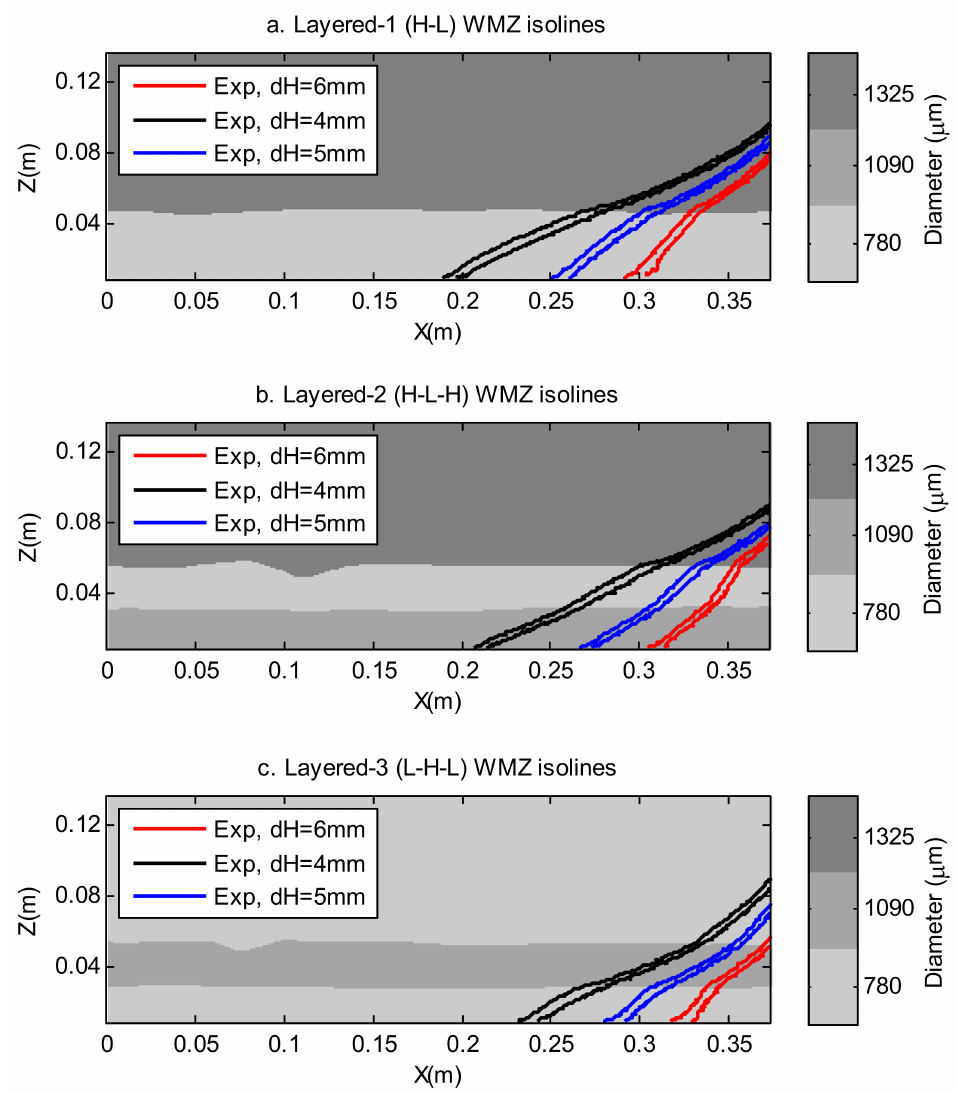
Figure 10. Experimental steady-state 25% (upper line) and 75% (lower line) salt concentration isolines 6 mm, 4 mm, and 5 mm. (( a ) High-Low, ( b ) High-Low-High, ( c )